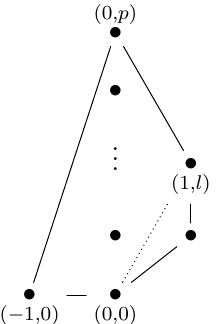
Figure 5 . Geometry realizing su ( p ) with one flavor. We show the added triangle, which is of minimal